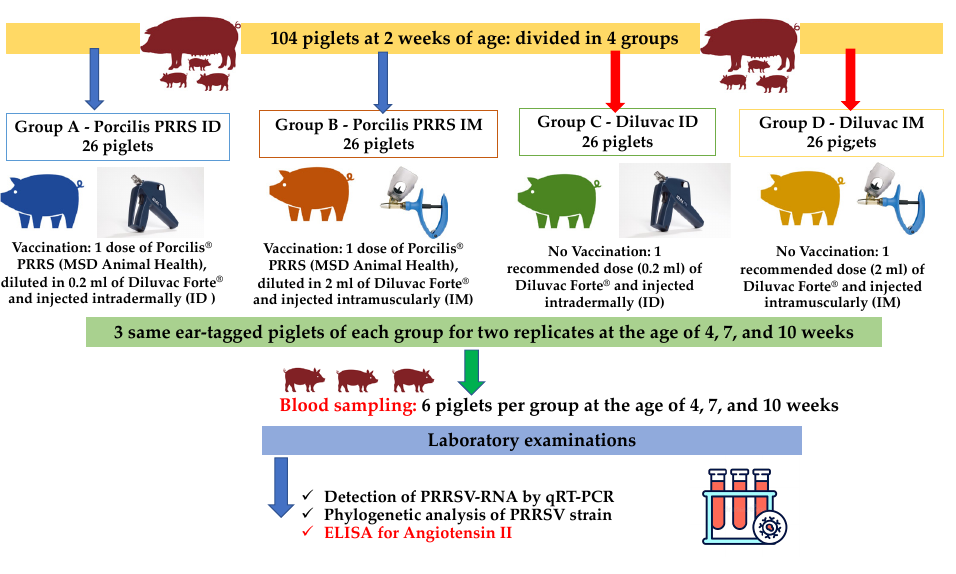
Figure 1. A flowchart of the trial design (experimental groups, vaccinations, sampling and laboratory examinations).